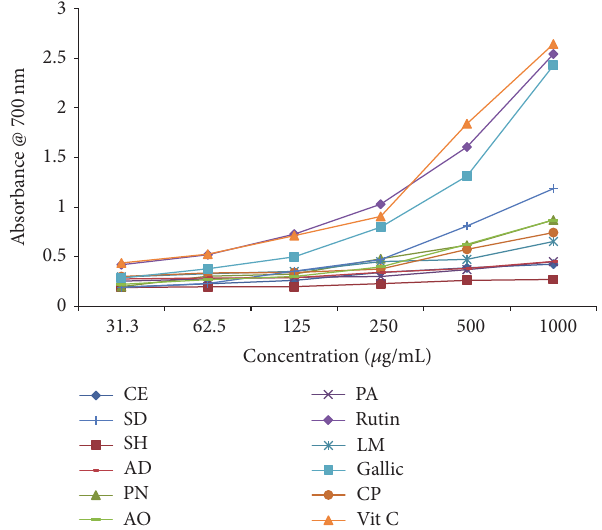
Figure 5: Ferric reducing antioxidant activity of selected antidi- abetic plants used in the southeast folklore medicine of Nigeria. CE, Chlorophora excelsa ; CP, Ceiba pentandra ; SH, Strophanthus hispidus ; SD, Synsepalum dulcificum ; PN, Picralima nitida ; AD, Anthocleista djalonensis ; PA, Persea americana ; AO, Anacardium occidentale; LM, Loranthus micranthus .